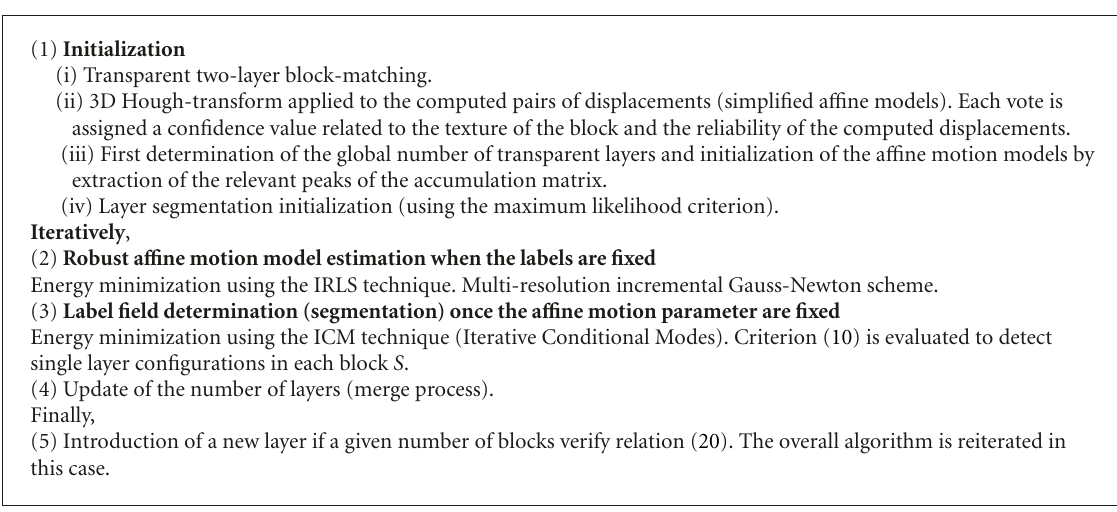
Algorithm 1: Joint transparent motion estimation and layer segmentation